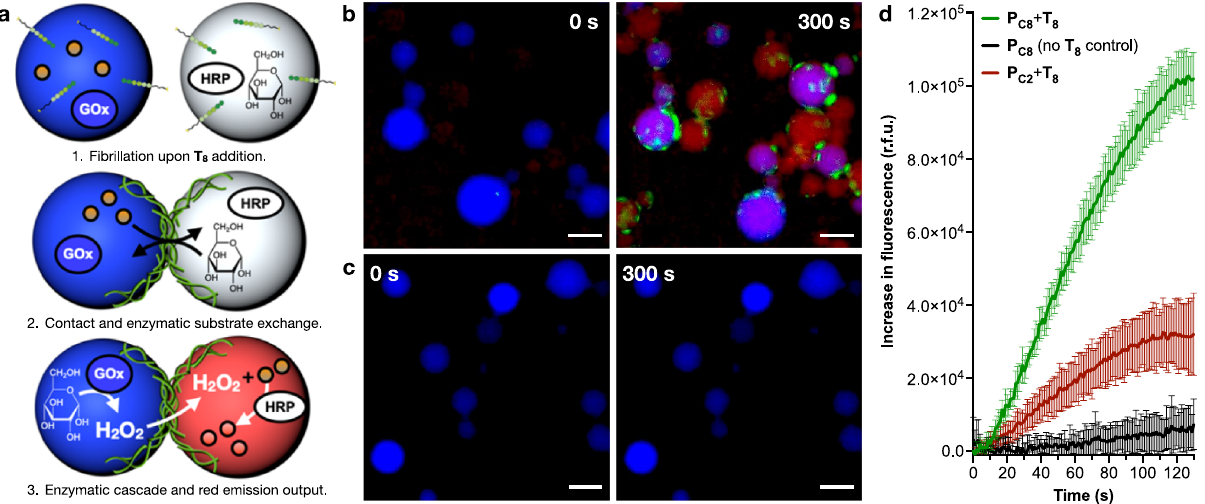
Fig. 4 Micro fi bre-mediated exchange of chemical contents between droplets to trigger a biocatalytic pathway. a Scheme illustrating the steps involved in content exchange between droplets and resulting enzymatic reactions. The non-emissive Amplex Red precursor (orange dots) is converted into red emissive resoru fi n (red dots). Note Span 80 has not been drawn for clarity. b , c Fluorescence micrographs before (0 s) and 300 s after the addition of octanal ( T 8 ). Experiments carried out in the presence ( b ) and absence ( c ) of the aldehyde precursor T 8 . Scale bars = 70 µ m. All experiments contain ThT at 5 µ M. d Bulk red emission of emulsions containing both droplet populations, either in the presence (red) or absence (black) of T 8 , corresponding to a fi brillating and non- fi brillating system, respectively. The red pro fi le shows a control sample with both droplet populations loaded with P P C2 T 8 is unable to self-assemble into fi bres 36 ; n = 3 (mean ±